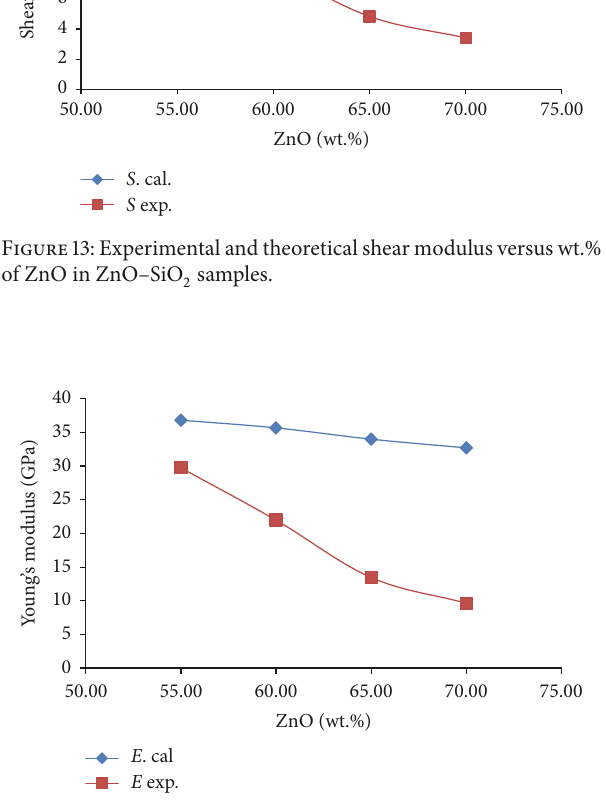
Figure 14: Experimental and theoretical Young’s modulus versus wt.% of ZnO in ZnO–SiO 2 samples.